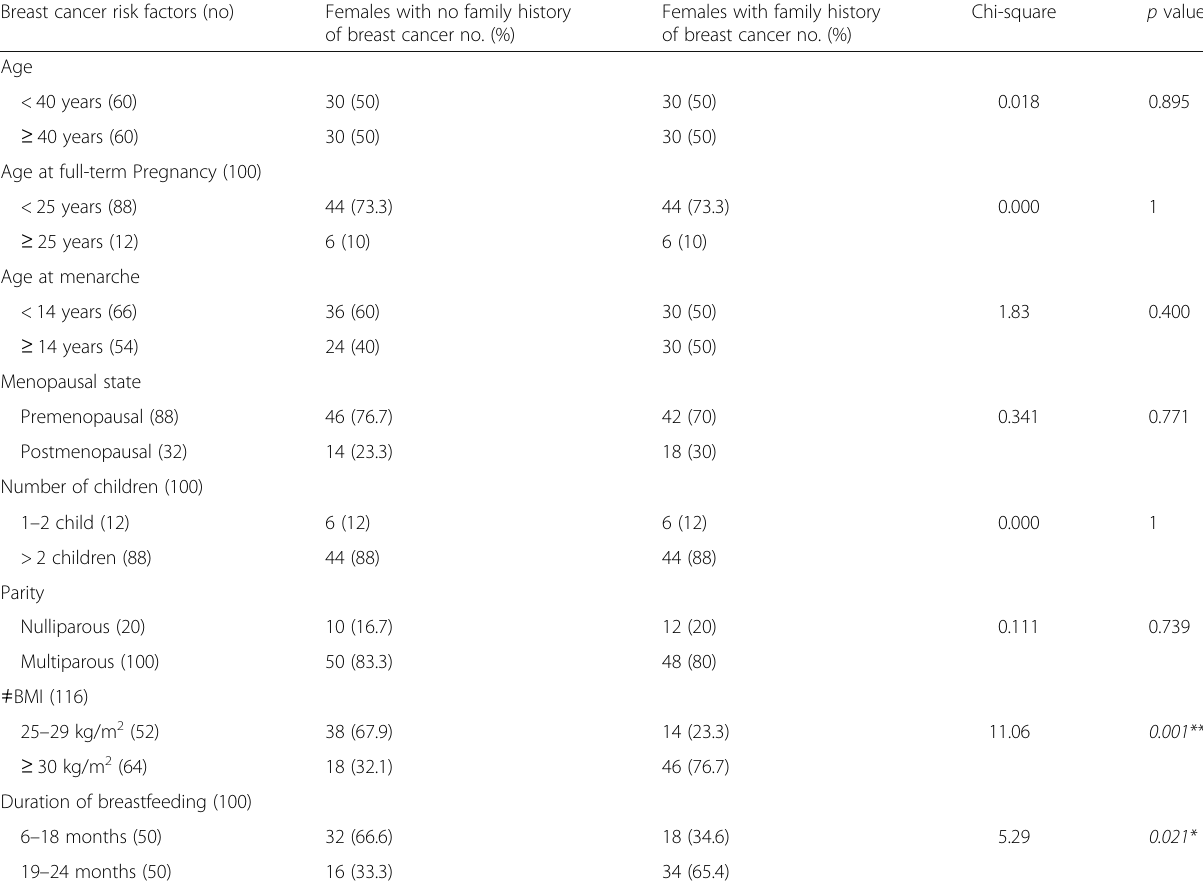
Table 1 The distribution of the number and percentages of breast cancer risk factors in females with and without family history of breast cancer Breast cancer risk factors (no) Females with no family history of breast cancer no.